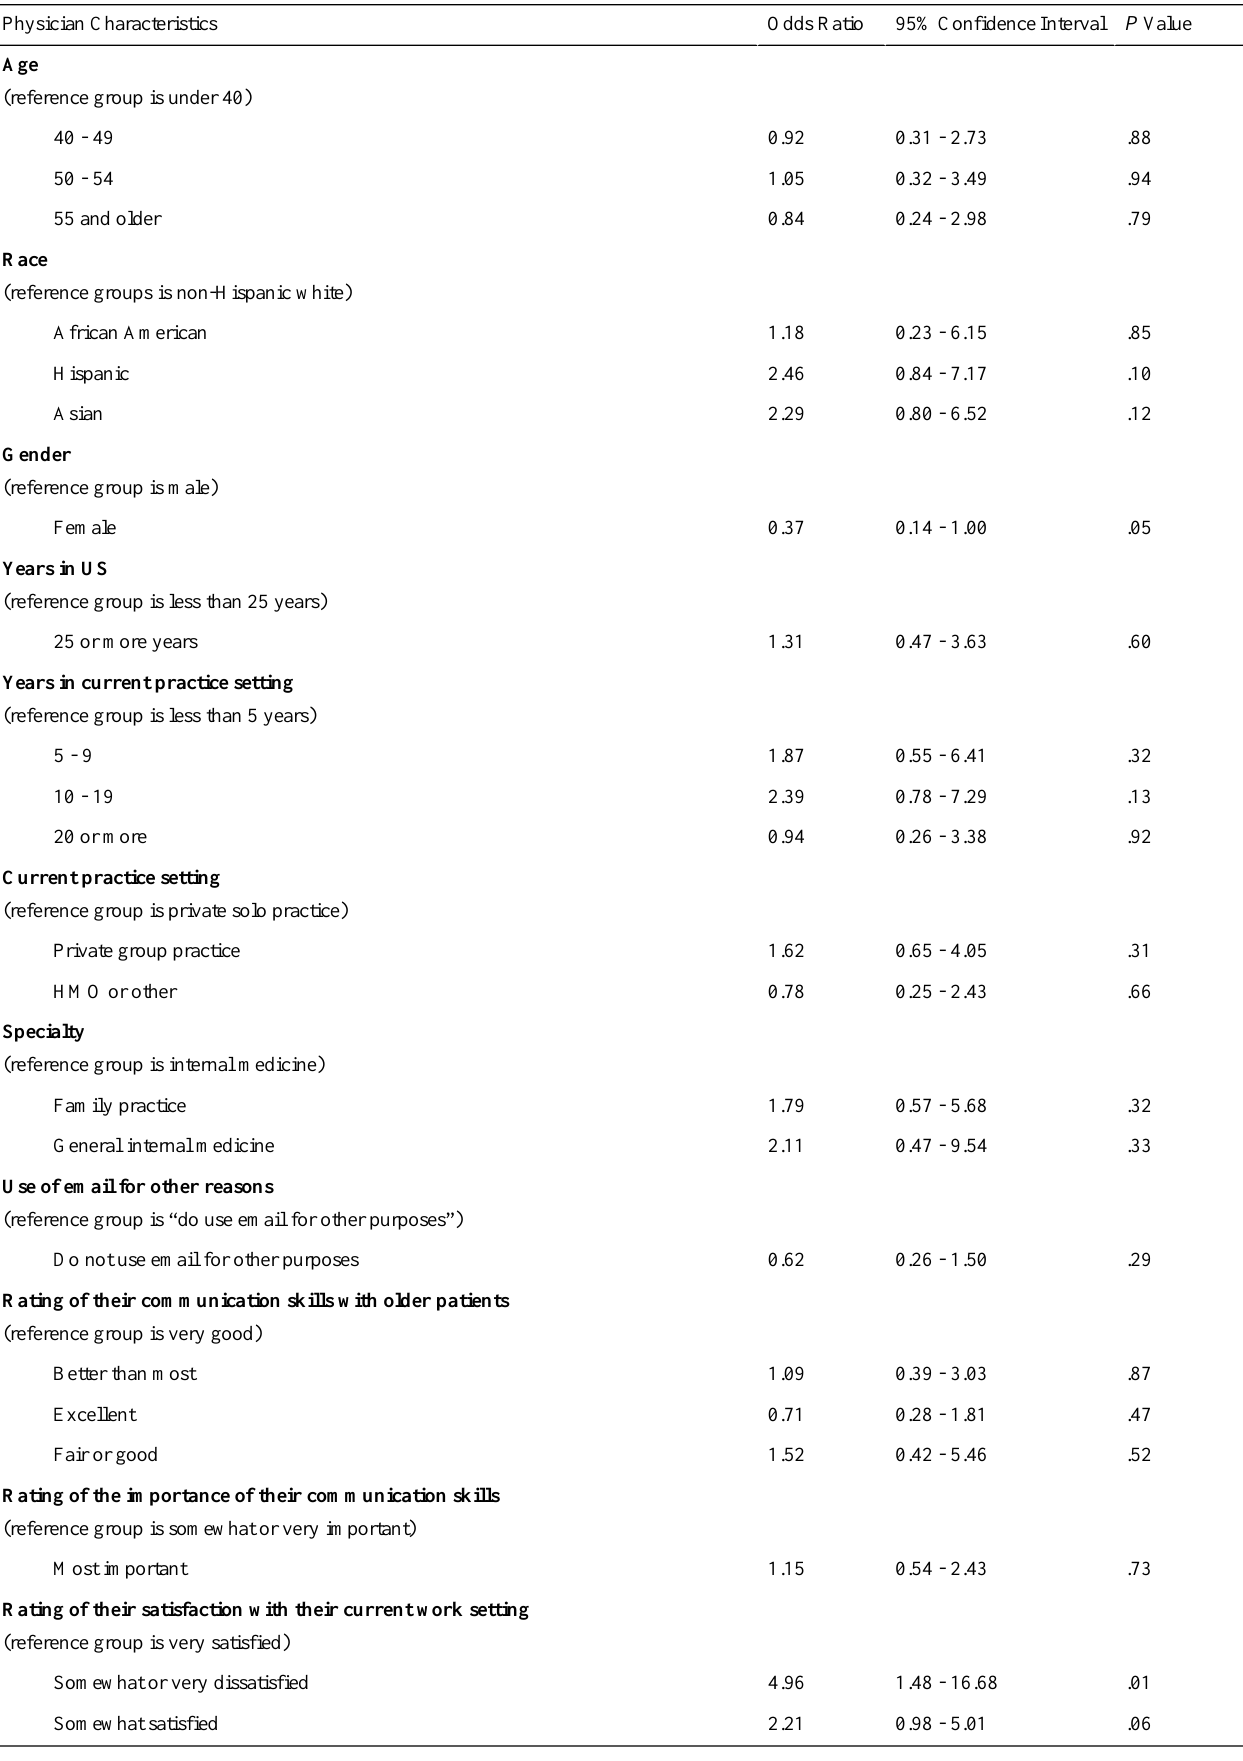
Table 4. Logistic regression analysis of physician enthusiasm to use email in 2003 (all physician characteristics were significant in univariate